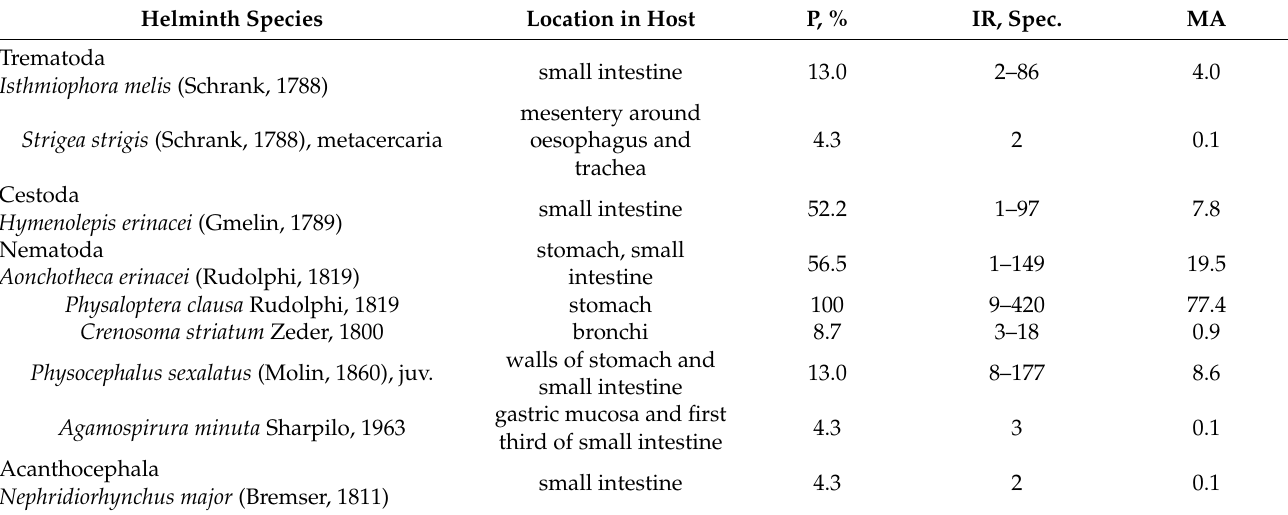
Table 1. Helminth fauna of Erinaceus roumanicus in Mordovia